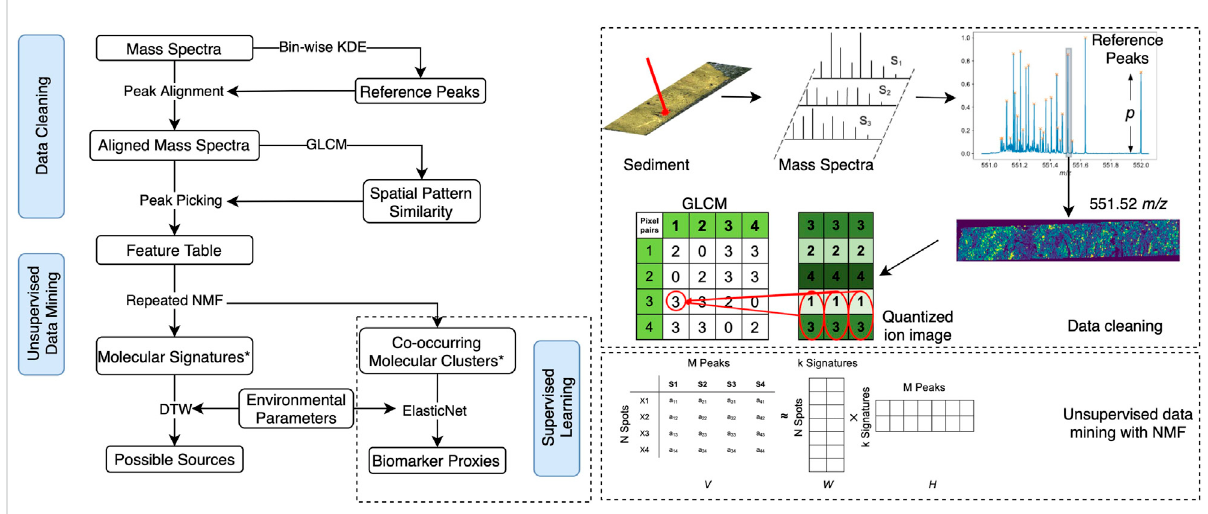
FIGURE 1 (A) Proposed work fl ow including data cleaning and data mining modules for the untargeted analysis of the sedimentary MSI dataset, supplemented by a supervised learning example to demonstrate its potential for the discovery of novel biomarker proxies on the basis of the proposed work fl ow. * Molecular signatures refer to the small sets of hidden features extracted by repeated NMF, and they denote the commonality of co-occurring molecules. By contrast, ElasticNet tries to fi nd the variability in these co-occurring molecules that correlate with certain environmental parameters. (B) Graph shows an example of the work fl ow, including the detection of reference peaks between m/z values 551.0 and 552.0, the calculation of the gray level co-occurrence matrix (GLCM), and the unsupervised data mining with non-negative matrix factorization